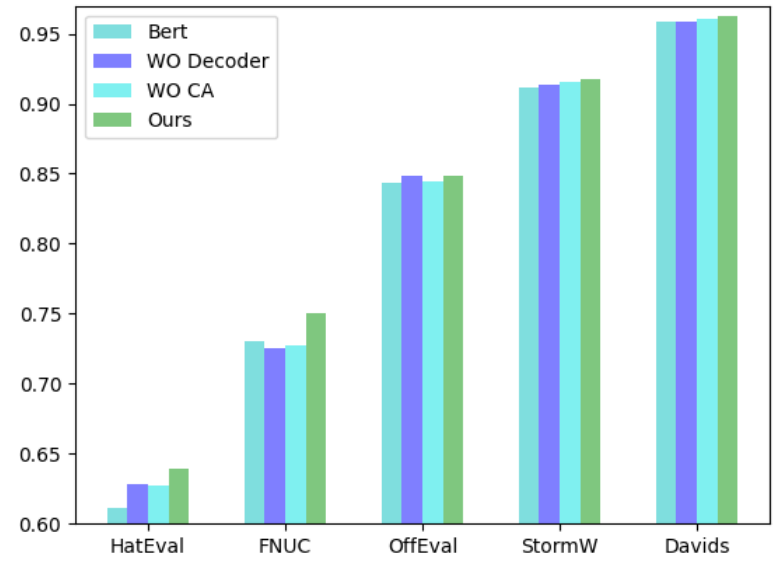
Figure 5. Accuracy results for the ablation